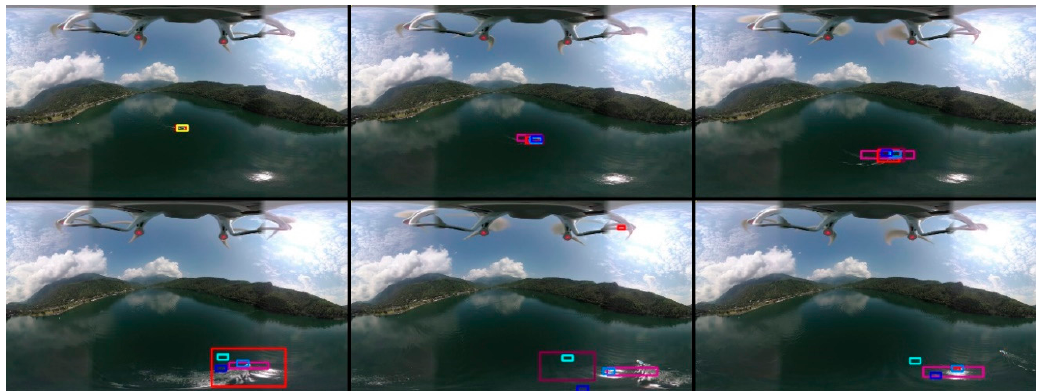
Figure 8. Tracking results on 360-degree video sequence 5 (tracking windows with different colors: MOSSE MIL MedianFlow BOOST TLD KCF GOTURN CSRT).